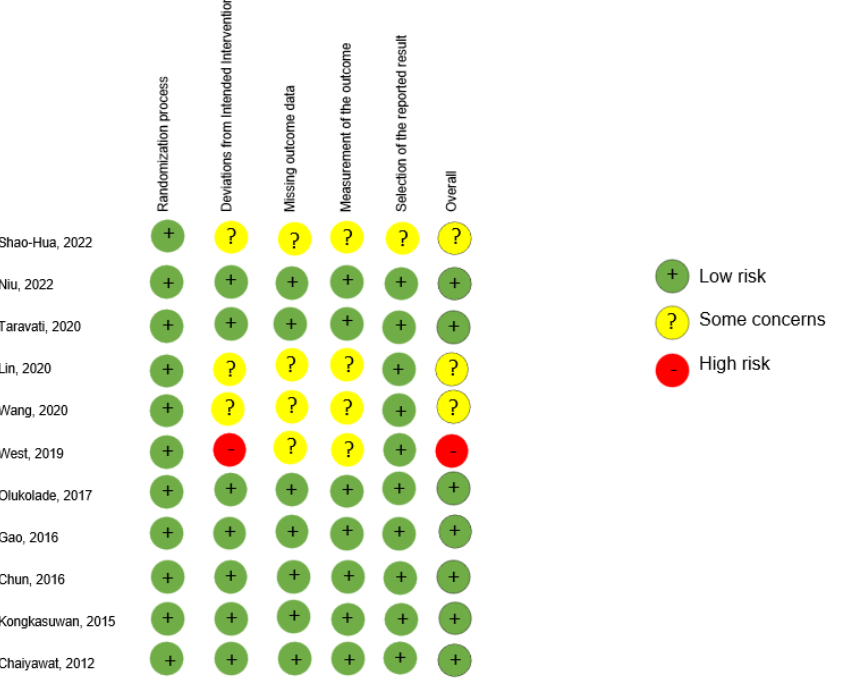
Figure 2. Risk of Bias assessment according to the Cochrane Collaboration’s tool (RoB 2.0) for randomised controlled trials. Higgins et al. (2011) [47].